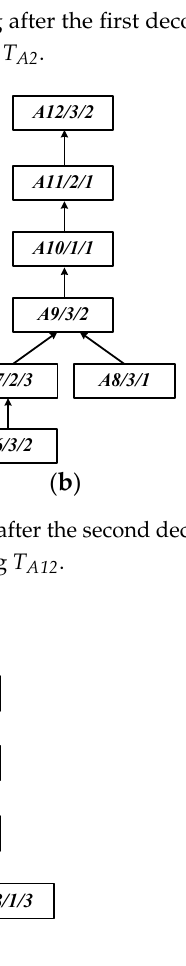
Figure 3. Each operation string after the first decomposition of complex product A : ( a ) Operation string T A1 ; ( b ) Operation string T A2 .